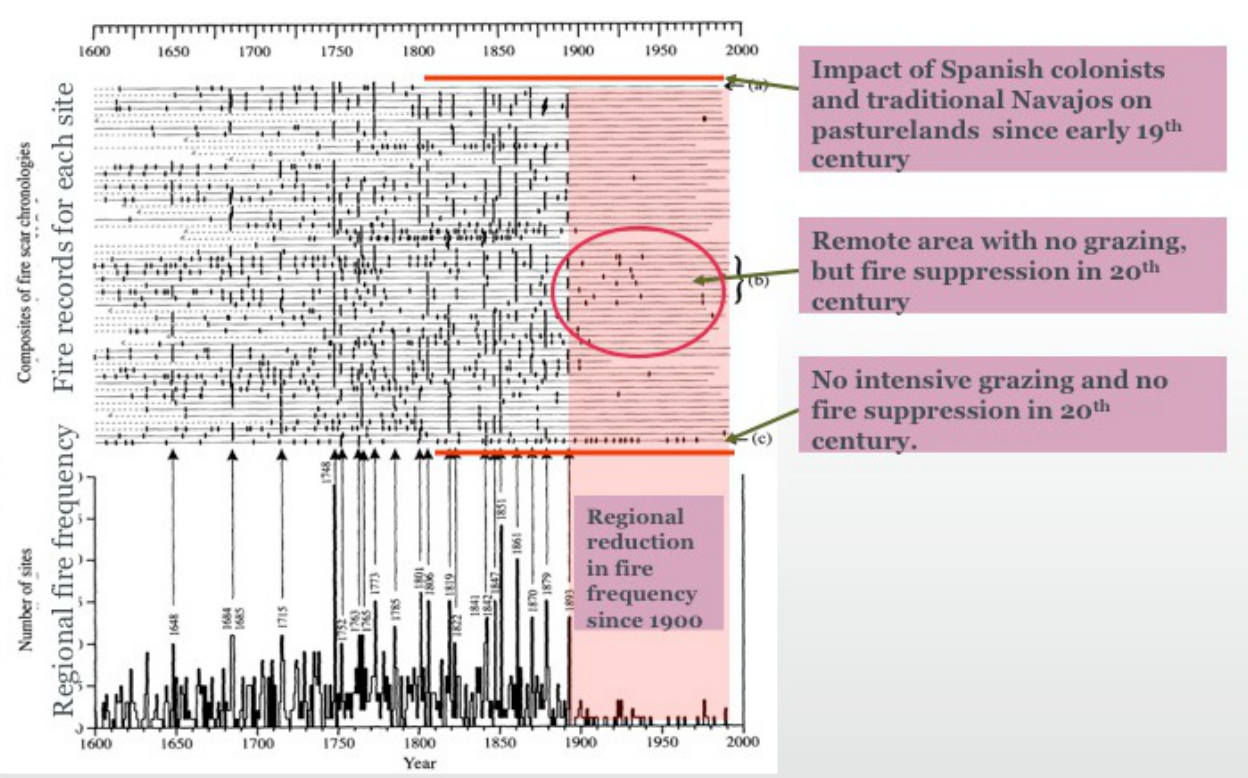
Fig. 3. Frequencies, thresholds, and alternate steady